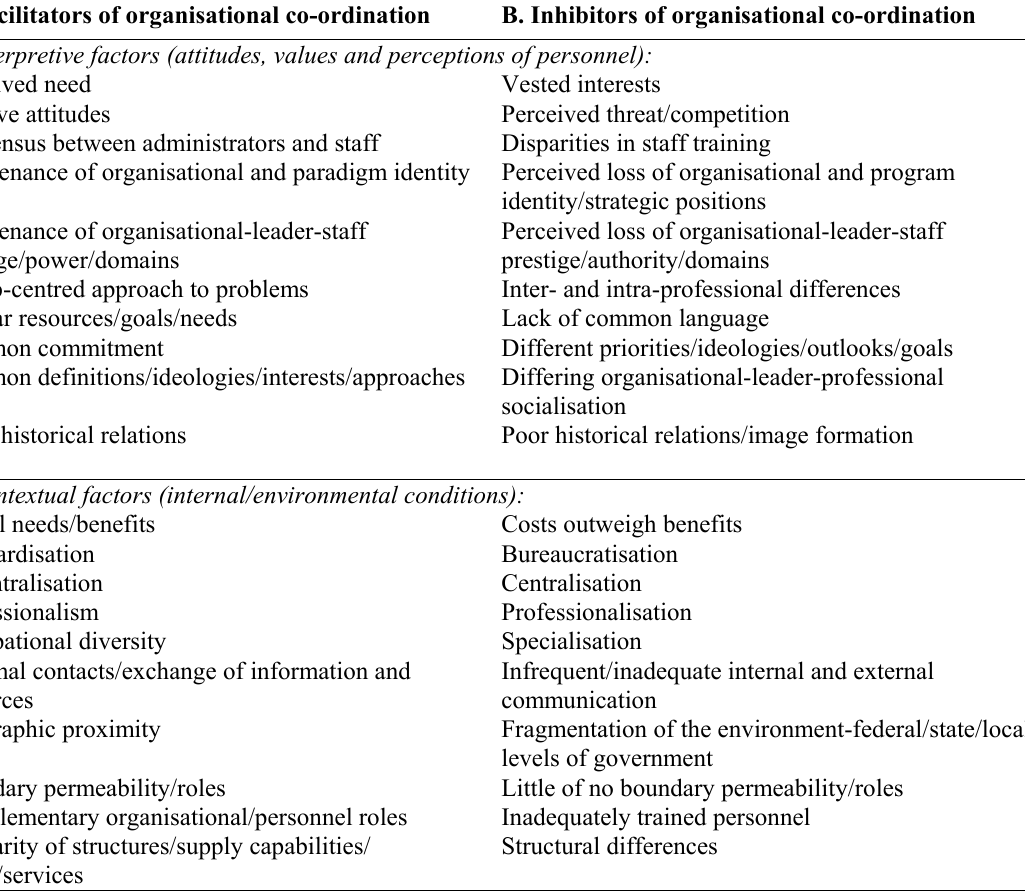
Table 1. Facilitators and inhibitors of organisational